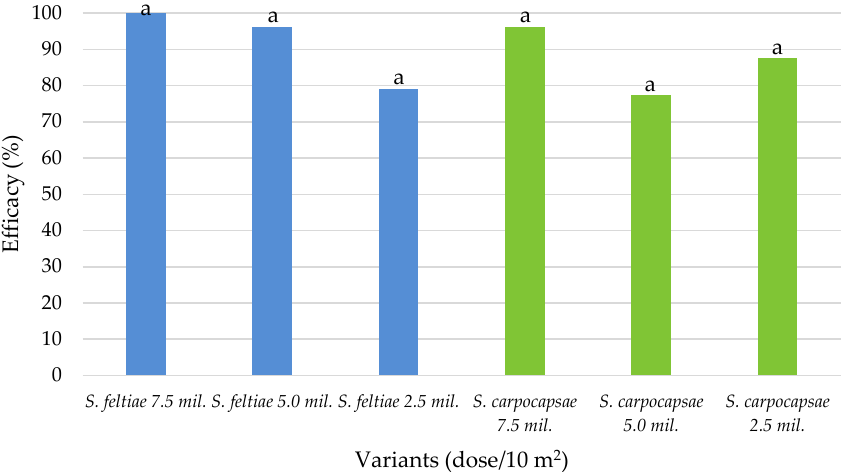
Figure 3. Average EPN efficacy on overwintered Colorado potato beetle populations in the 2018 field trial, Zagreb. Bars with the same letters are not significantly different ( p < 0.05, Duncan’s New MRT test).